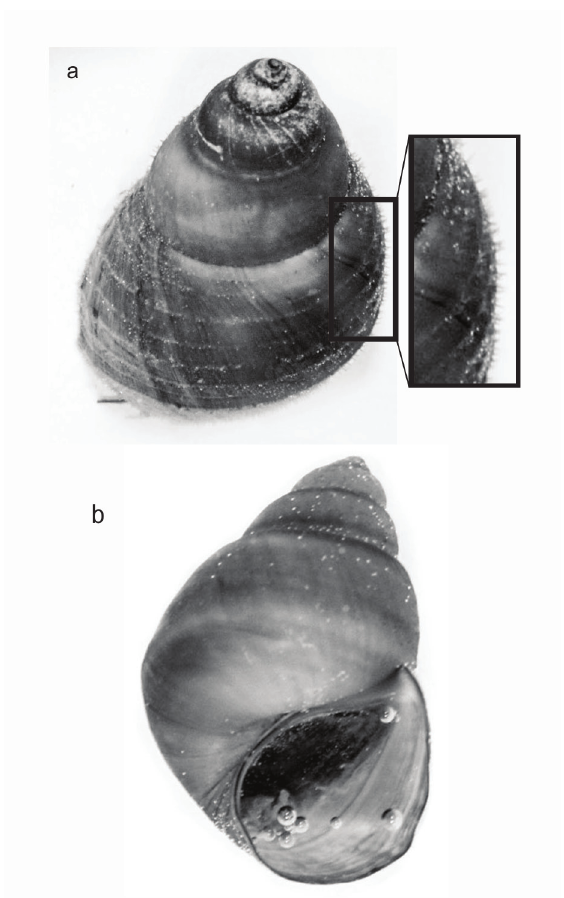
Figure 4 - Shell morphology of Sinotaia cf quadrata . a. Histric shell (individual size: 17.16 mm). b . Glabrous shell (individual size: 24.3 mm)